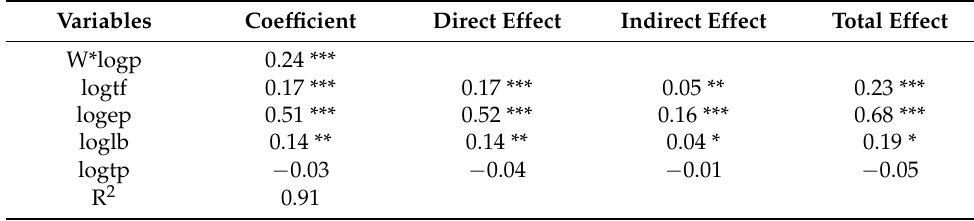
Table 10. Results of the SLM with spatial fixed effects for the western region in China. Variables